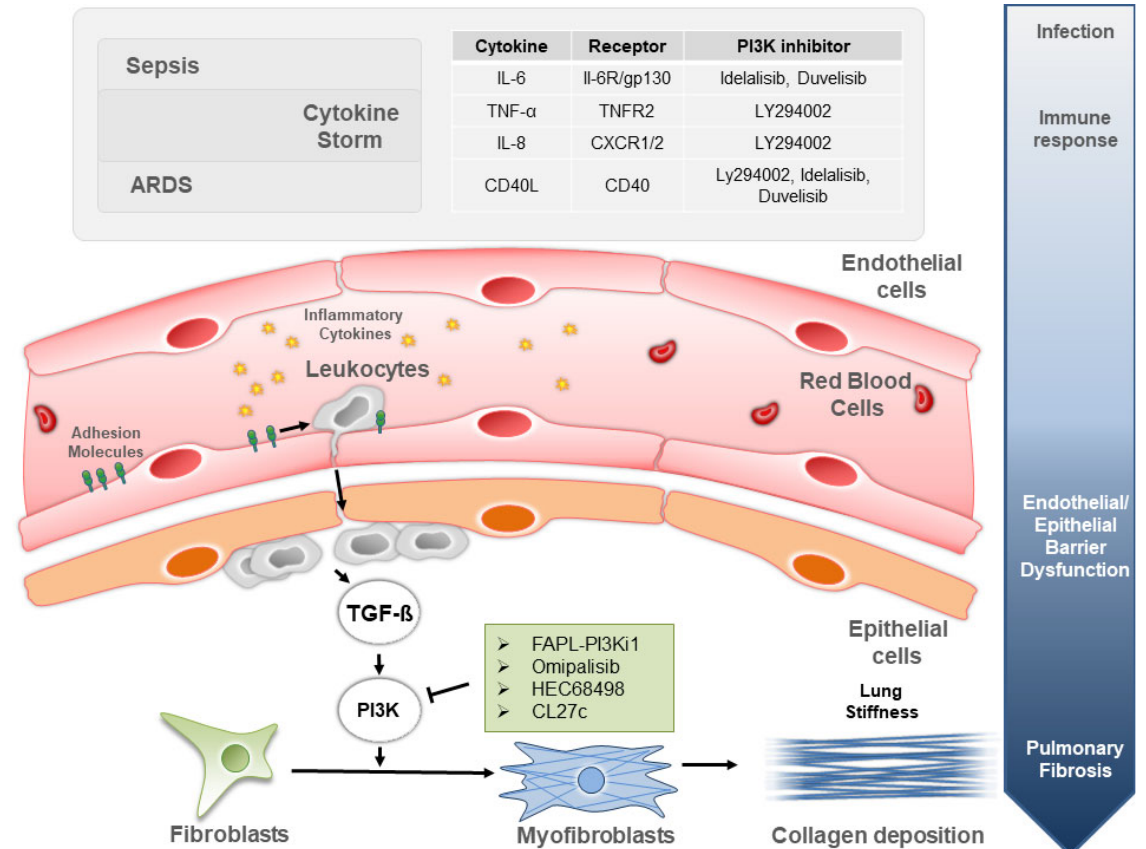
Figure 1. The PI3K signaling involvement in mechanisms and treatments of lung fibrosis induced by sepsis and ARDS.